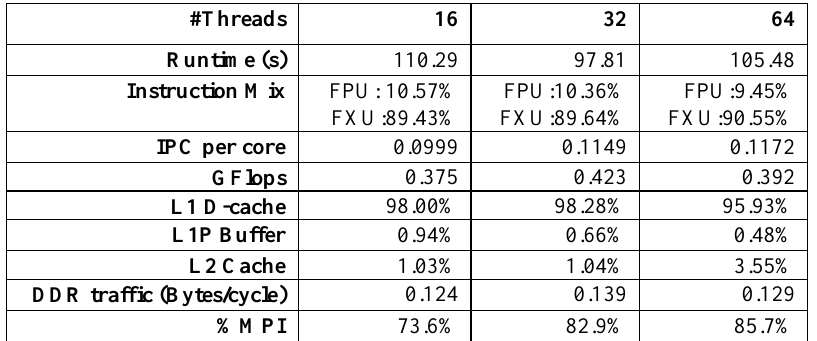
Table 4. Performance (per node) comparison of PEQdyna with 200m on 128 Nodes